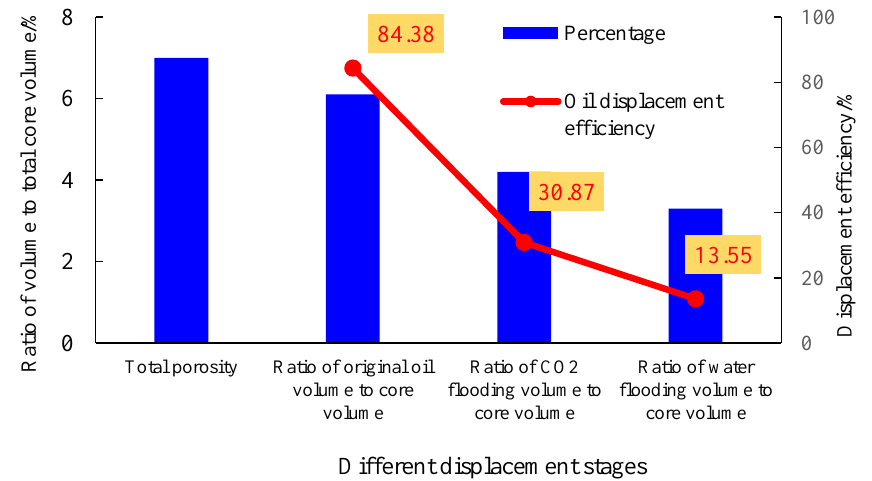
Figure 12. The Y40–92 core displacement efficiency and ratio of volume to total core volume in Figure 12. The Y40 – 92 core displacement efficiency and ratio of volume to total core volume in dif- different stages. ferent stages.